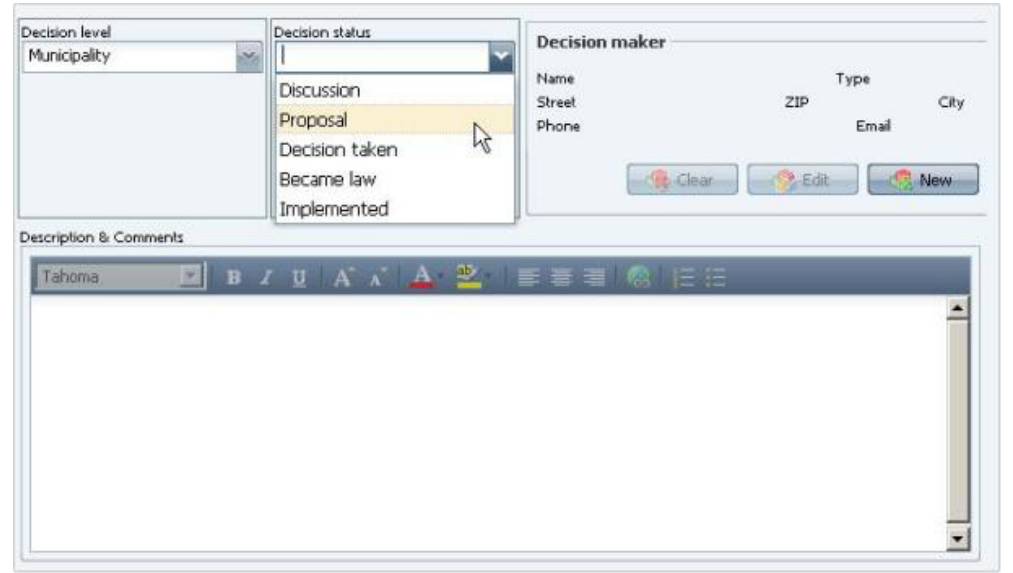
Figure 8. A step form for the first step from Figure